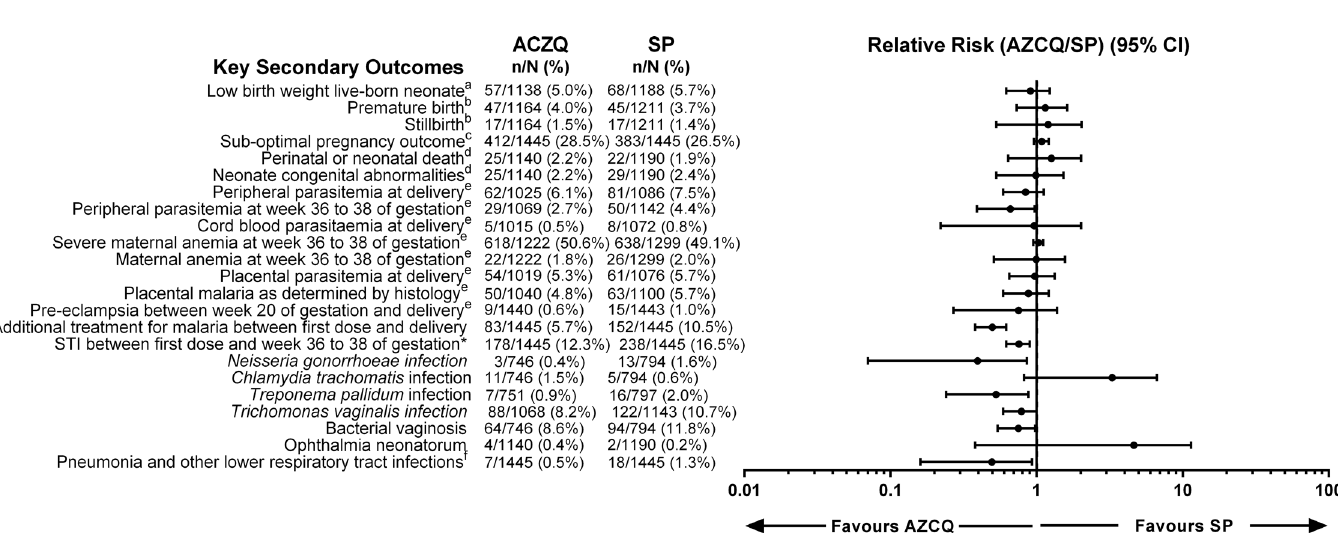
Fig 2. Incidence of secondary outcomes in the ITT population. a Denominators are the number of subjects with a premature or full-term live birth and a non-missing birth weight. b Denominators are the number of pregnancy outcomes, excluding those that were unknown/missing. c Including neonatal death and congenital malformations. d Denominators are the number of subjects with a premature or full-term live birth. e Denominators are the number of subjects with available measurements. f STI = sexually transmitted infection between first dose and Week 36 to 38 of gestation including T . pallidum , N . gonorrhoeae , C . trachomatis (diagnosed based on clinical presentation prior to week 36 – 38 and/or positive lab test results between week 36 – 38). g Diagnosed based on positive result at week 36 to 38 of gestation. h Between first dose and